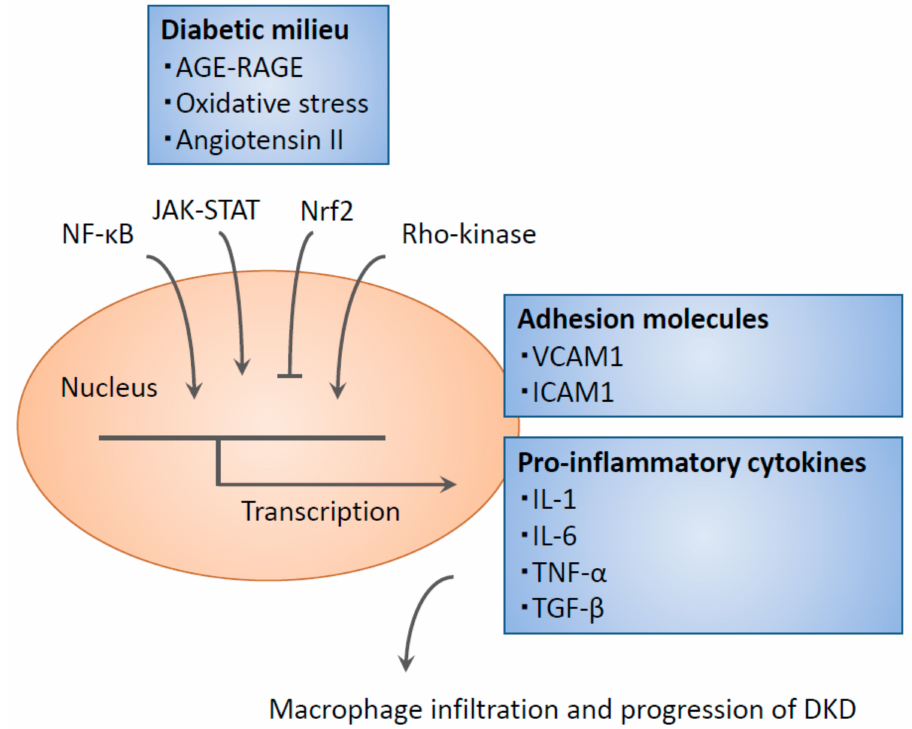
Figure 1. In the diabetic kidney, advanced glycation end products (AGEs) and oxidative stress activate a variety of signaling cascades to induce monocyte infiltration. In addition, chemokines drive inflammation, leading to macrophage-mediated tissue injury. DKD, Diabetic kidney disease; RAGE, receptor for AGE; VCAM1, vascular cell adhesion molecule 1; ICAM1, intercellular adhesion molecule 1; JAK-STAT, Janus kinase / signal transducer and activator of transcription; NF- κ B, Nuclear factor Kb; Nrf2, nuclear factor-2 erythroid related factor 2; TNF- α , tumor necrosis factor α ; TGF- β , transforming growth factor β